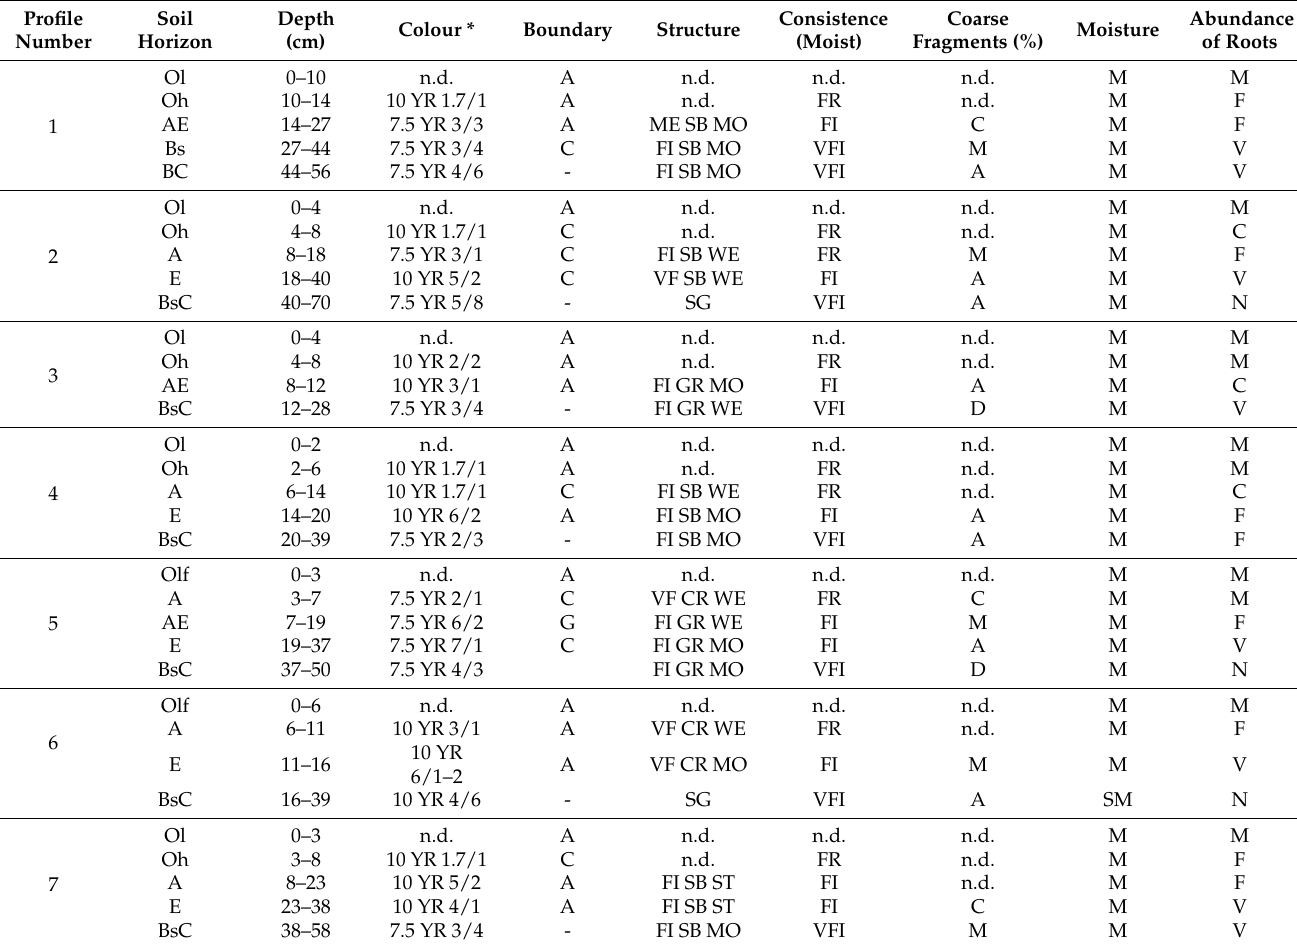
Table A1. Morphological characteristics of the studied